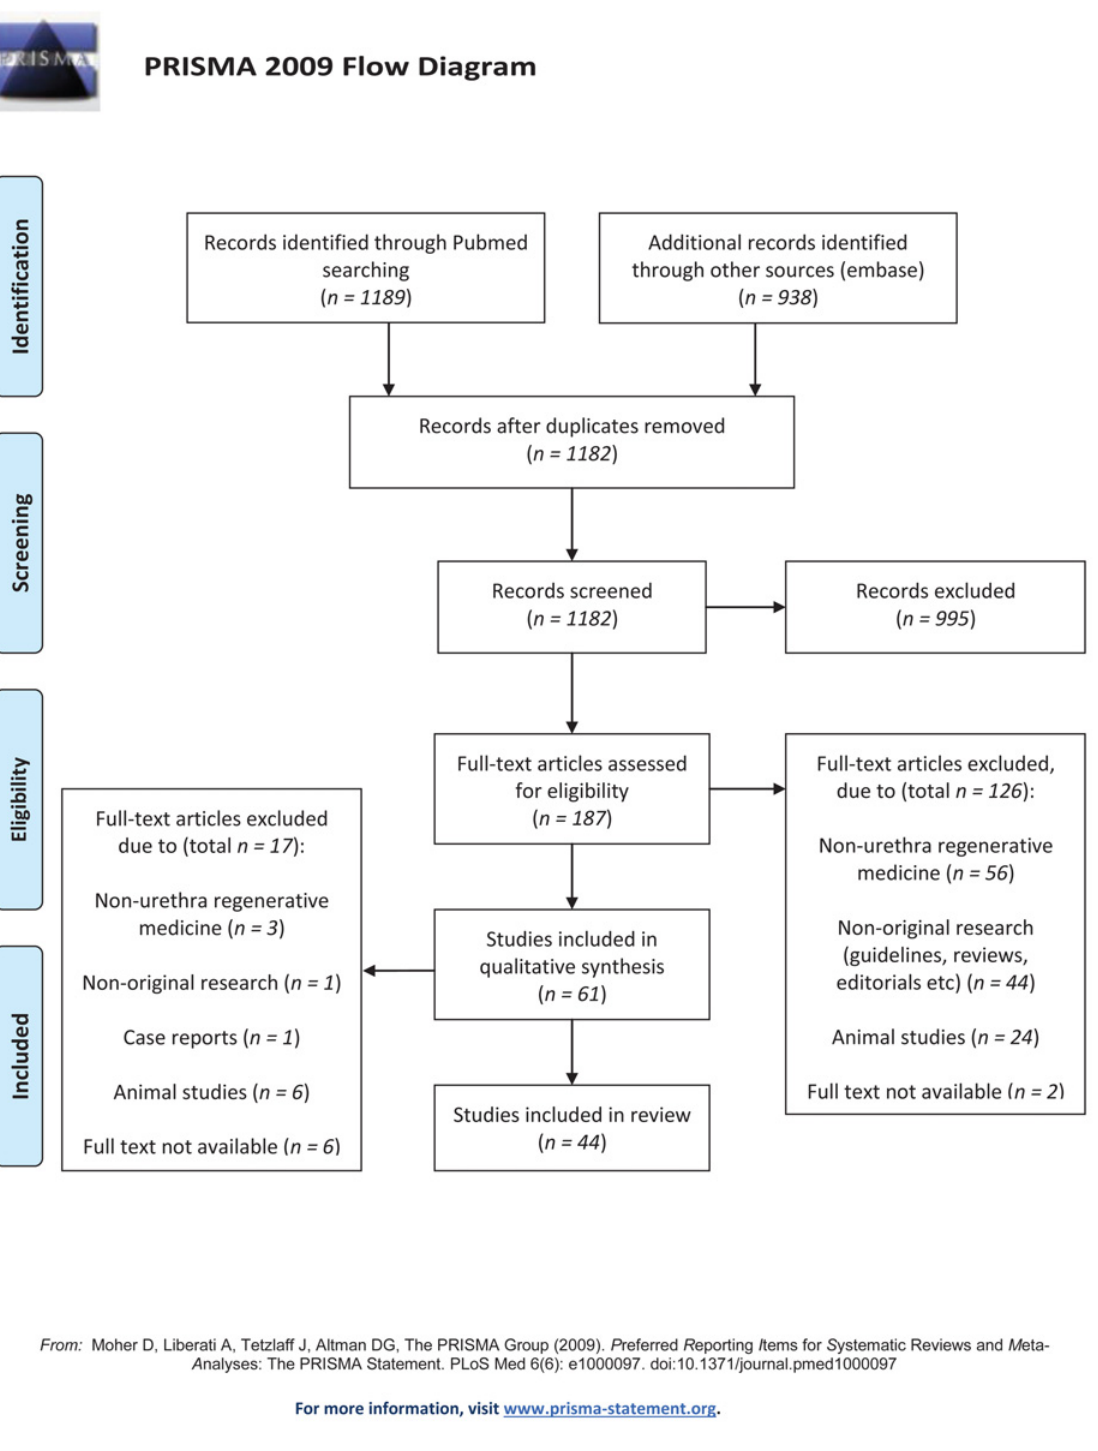
Fig 1. Search strategy and selection of the studies for the present review (n = 44). The database search was performed on 5 November 2013 according to the PRISMA statement [4]. For more details on the search strategy see Methods section.